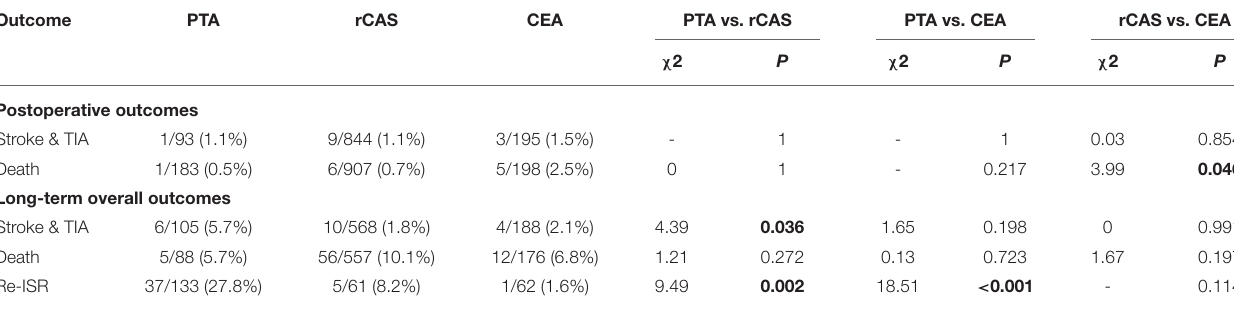
TABLE 3 | Comparison of outcomes in the PTA, rCAS, and CEA groups. Outcome PTA rCAS CEA PTA vs. rCAS PTA vs. CEA rCAS vs. CEA χ 2 P χ 2 χ 2